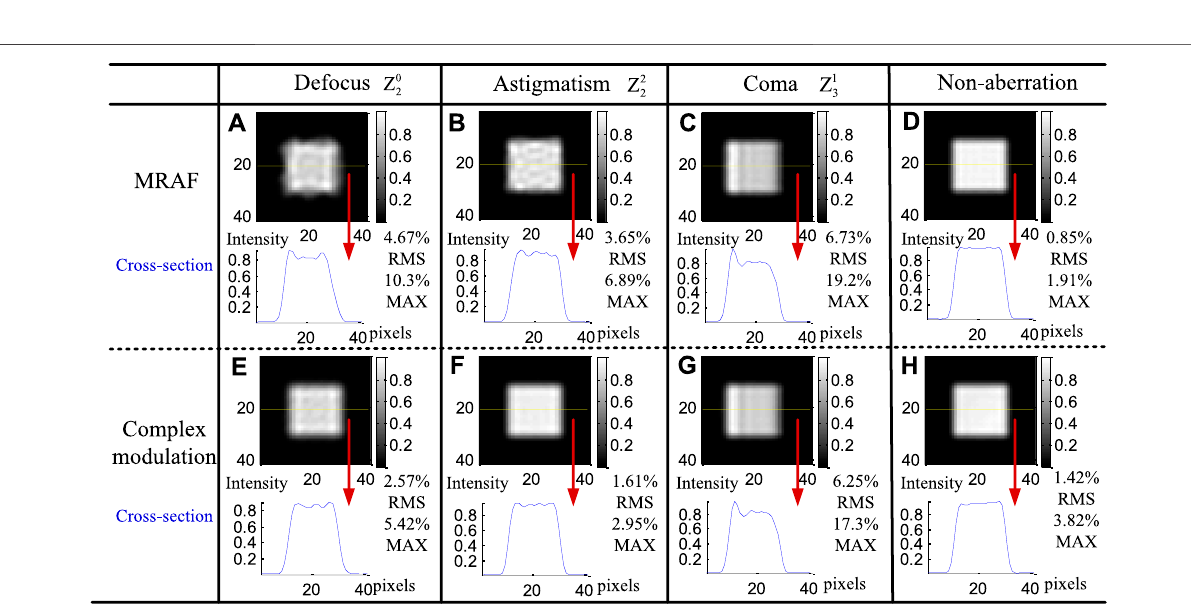
evaluated by cross section and marked with the yellow dotted line in the fi gure. Here, the ROI (region of interest) is selected from the 11th ~ 25th pixels for the uniformity calculation.